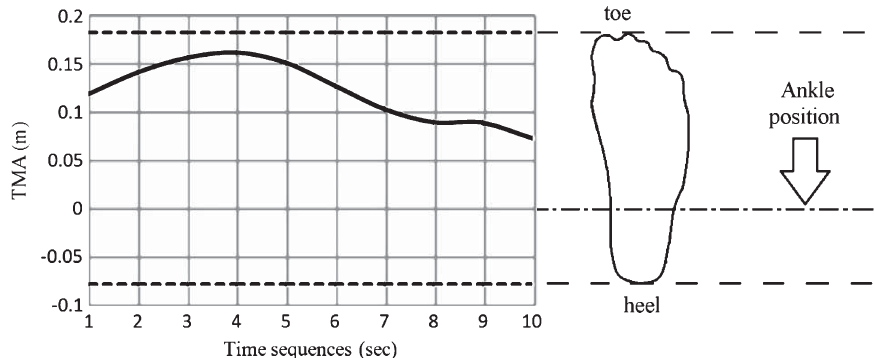
Fig. 9. TMA values during lifting time with its boundaries and relation with heel and toe. The solid lines are the calculated profile of TMA of segment of subjected model for simulated motion and broken lines are boundaries of base of support considered as margins of stability.